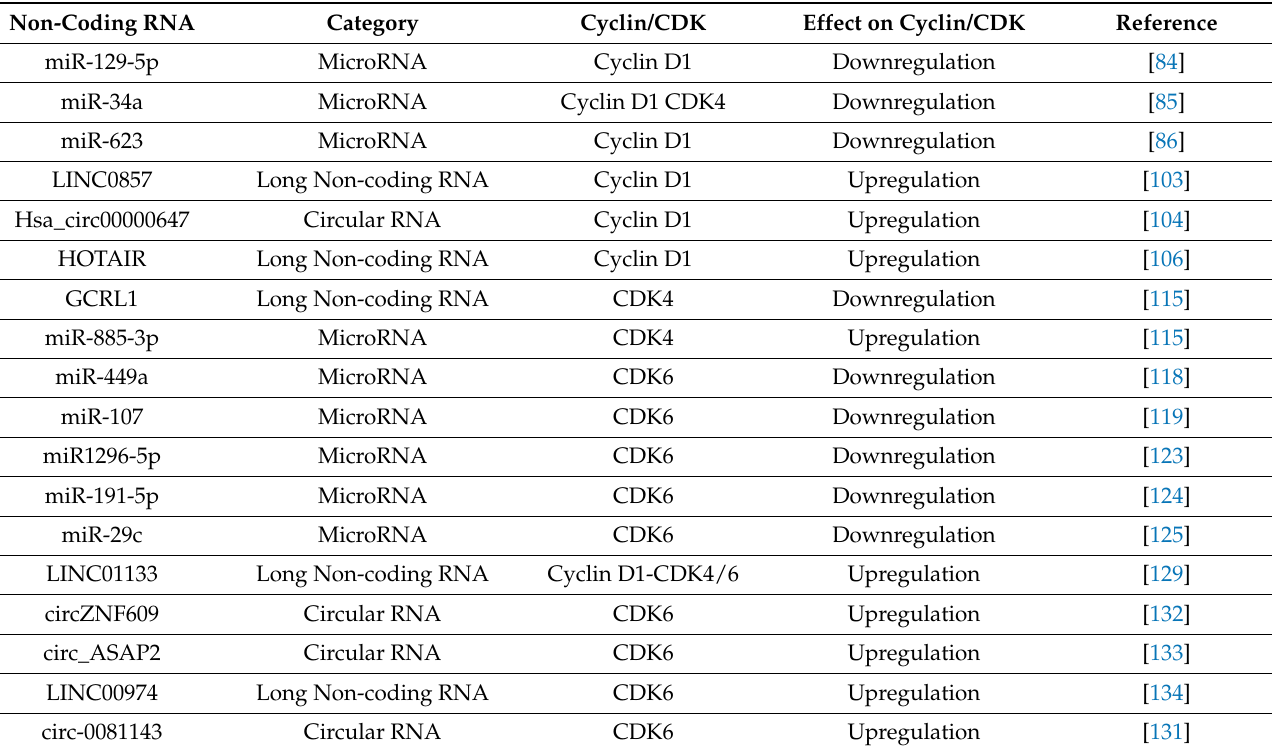
Table 4. The non-coding RNAs regulating Cyclin D1-CDK4/6 axis in gastric cancer. Non-Coding